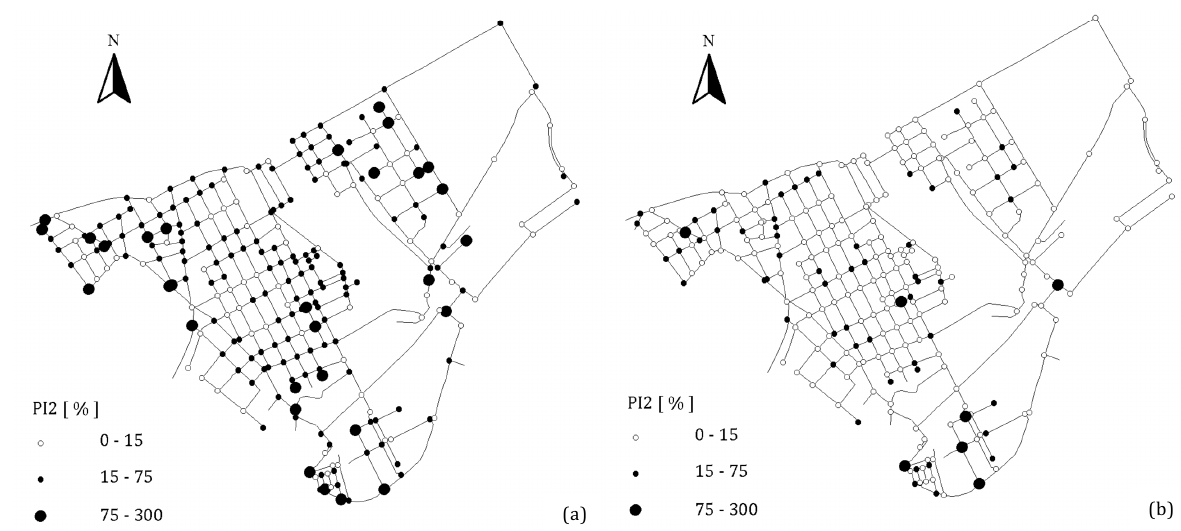
Figure 7. PI2 node values: ( a ) intermittent distribution with underground tank and ( b ) intermittent distribution with rooftop